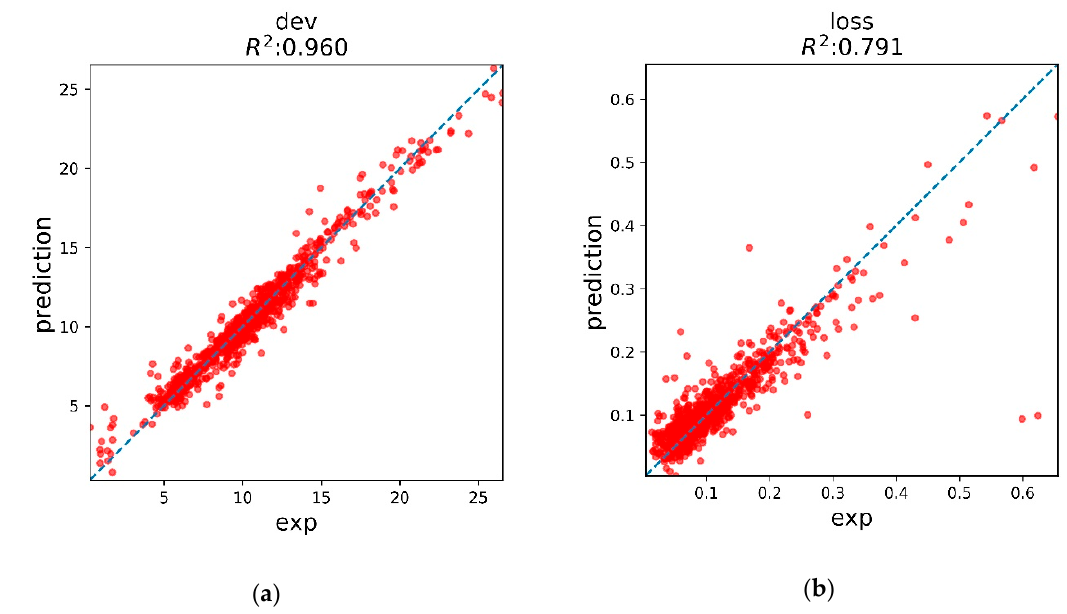
Figure 9. Optimization of training GPR models: ( a ) Hyper parameters search of deviation angle model; ( b ) Hyper parameters search of total pressure loss; ( c ) Optimization curve of models.